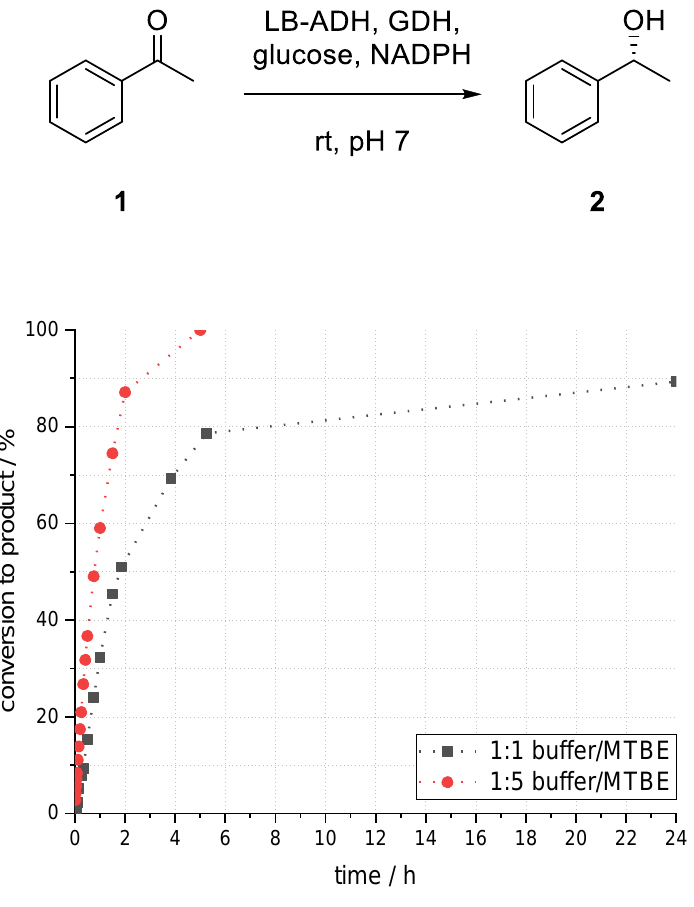
Figure 3. Biphasic ADH-catalyzed reduction of acetophenone ( 1 ) to 1-phenylethanol ( R )- 2 in a bu ff er / methyl tert -butyl ether (MTBE) system. c substr (overall): 50 mM, temperature: room temperature, catalyst loading: 2 U mL − 1 . LB: Lactobacillus brevis .